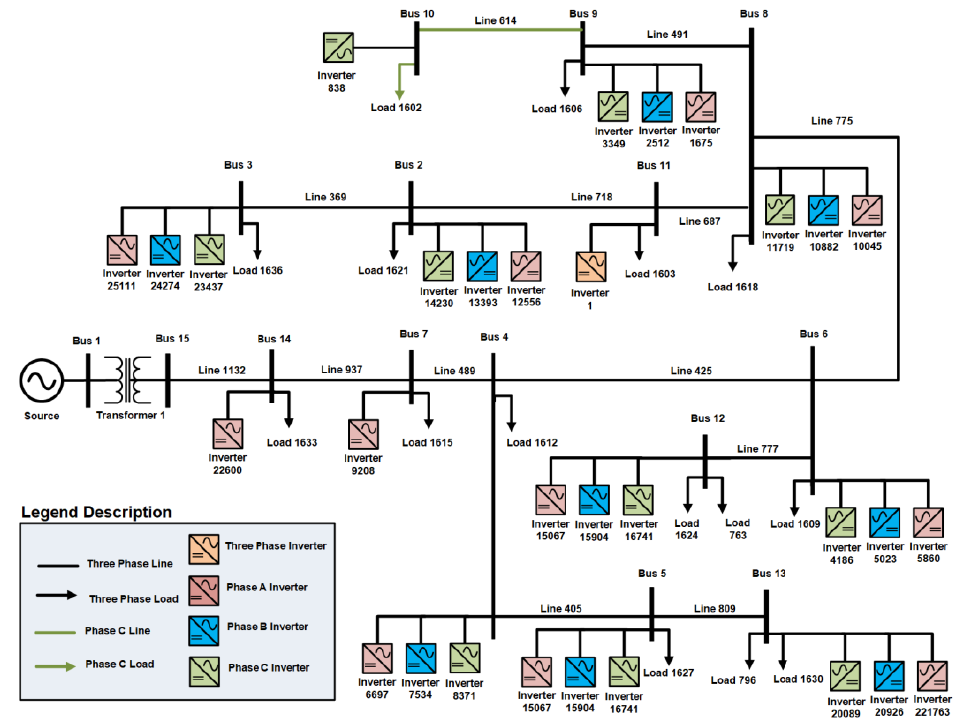
Figure 4. One-Line Diagram of NG Distribution Feeder.